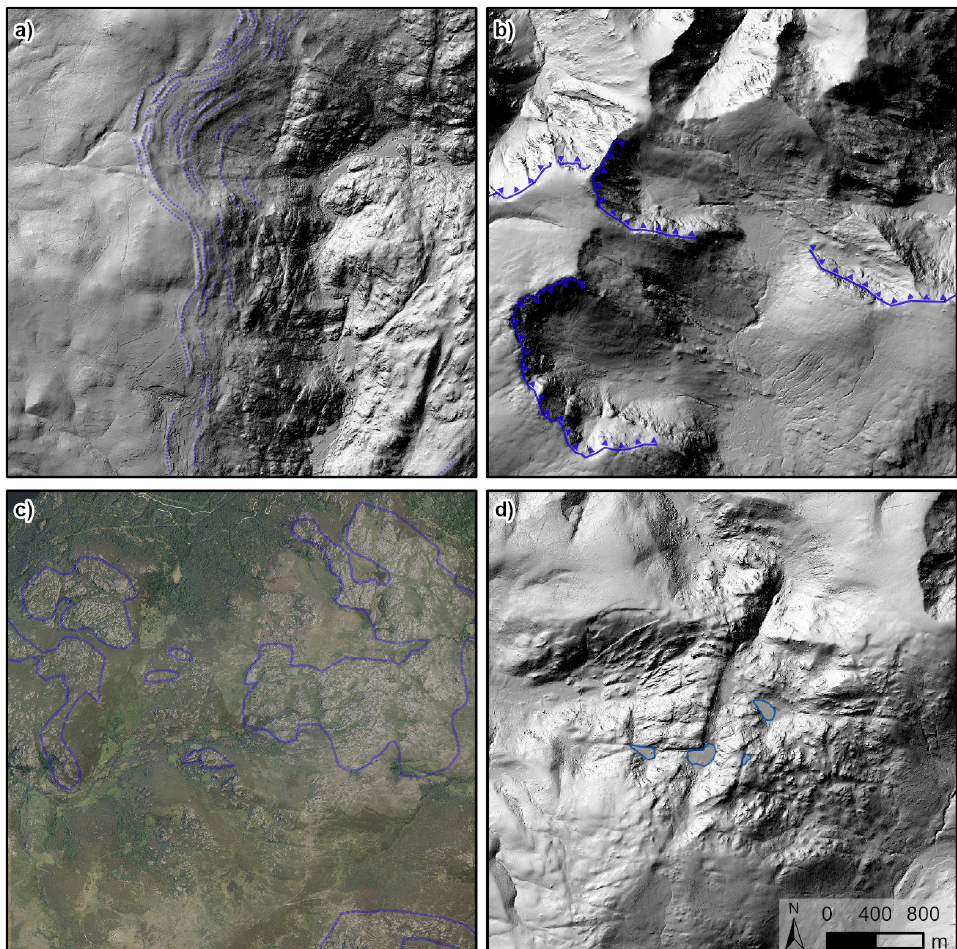
Figure 4. Examples of glacial landforms through hill-shade DEM. ( a ) Moraine ridges; ( b ) cirque scarps; ( c ) roche moutonnée; and ( d ) glacial lakes. Source: DEM with a 2 m spatial resolution from LiDAR data